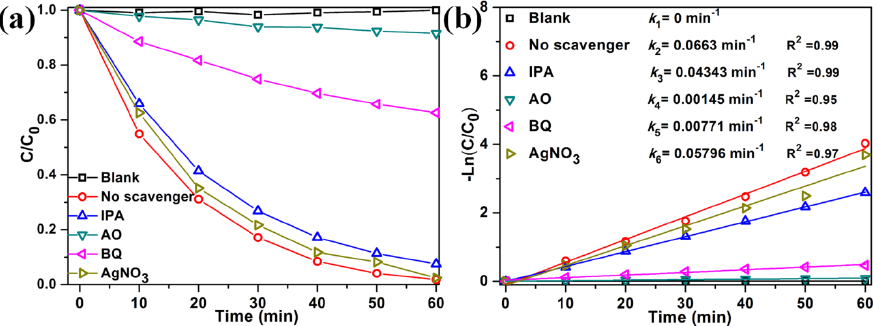
RhB over 3%M-Bi under visible light (λ > 400 nm).